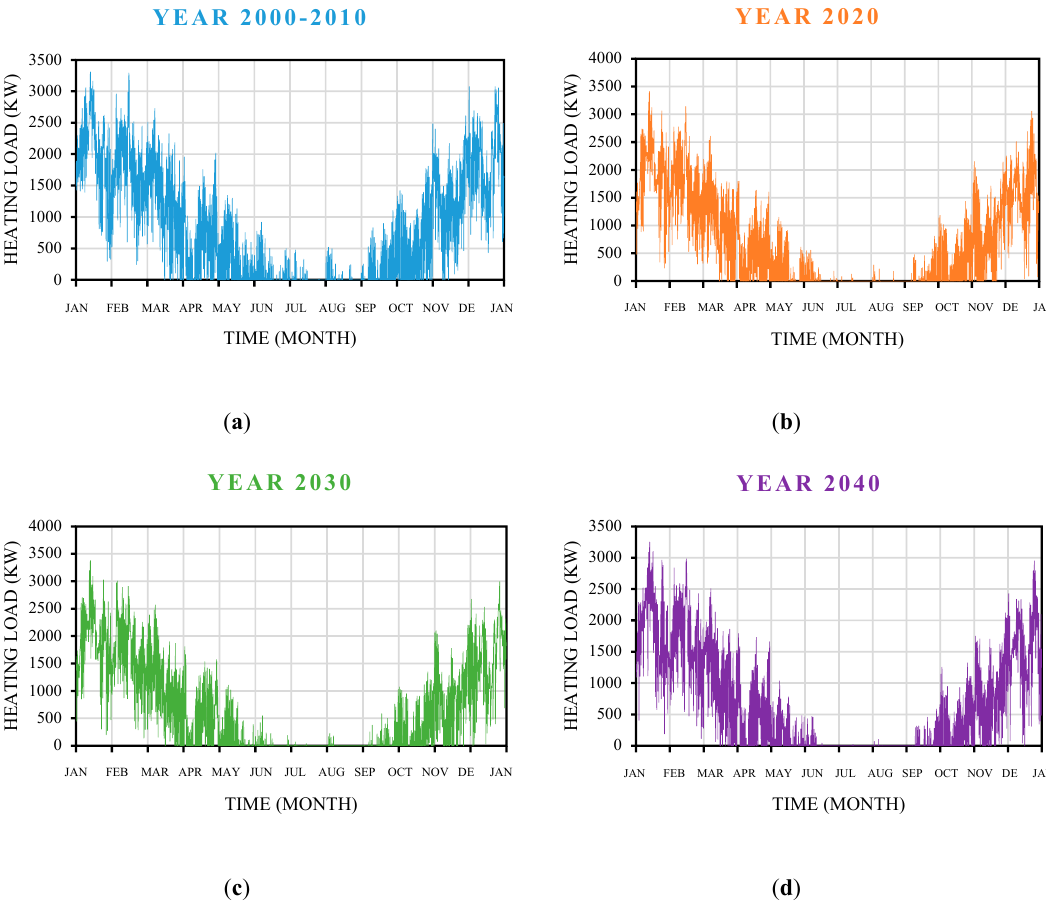
Figure 13. Hourly simulation of the heating load in different years diagrams: ( a ) Average of the heating load (kW) for the years between 2000 and 2010; ( b ) heating load (kW) in the year 2020; ( c ) heating load in the year 2030; and ( d ) heating load (kW) in the year 2030.